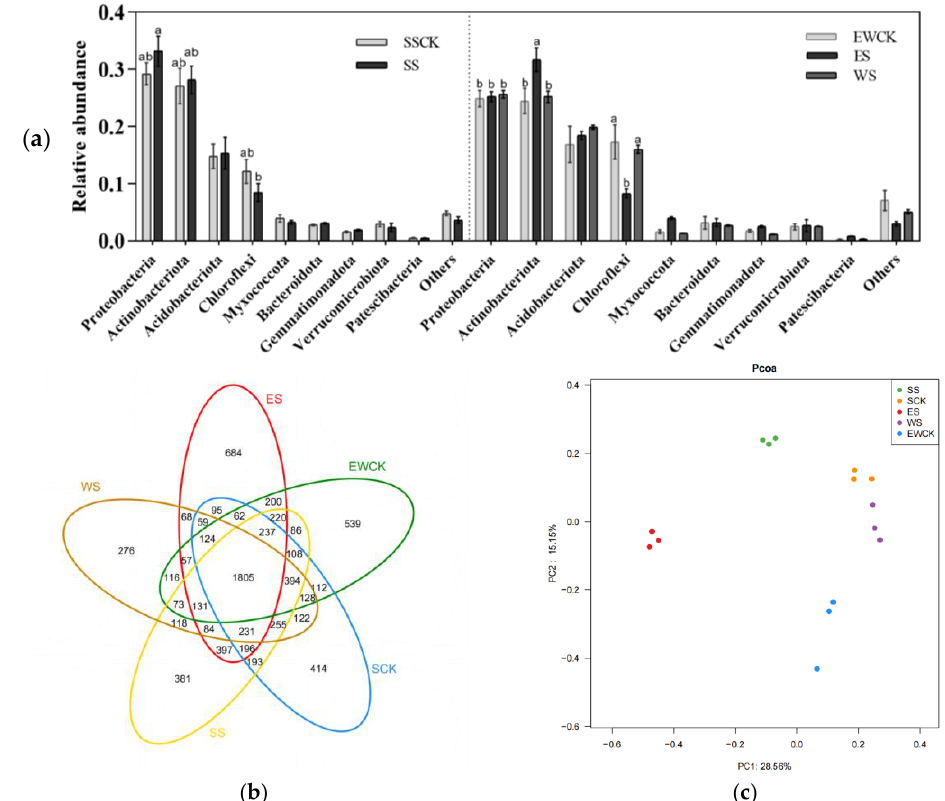
Figure 7. ( a ) Soil microbe relative abundances at different phylum levels of roadside trees for ecological shading (Note: Different lowercase letters indicated significantly differences among shading treatments, and the controls of SSCK and EWCK using the LSD test at p < 0.05. Bars represent standard errors ( n = 3); ( b ) Venn diagram of soil microorganisms of the tea plantation under roadside tree ecological shading (Note: Different colors represent different samples from different ecological shading treatments. Areas where two circles of different colors overlap and marked with the number 100 mean that both samples had 100 of the same sequences with the same OTUs); ( c ) Principal coordinate analysis (i.e., PCoA) of soil microbial communities based on the Bray–Curtis dissimilarity matrices across different ecological shading treatments (Note: The percentage variation explained by the plotted principal coordinates is indicated on the axes).